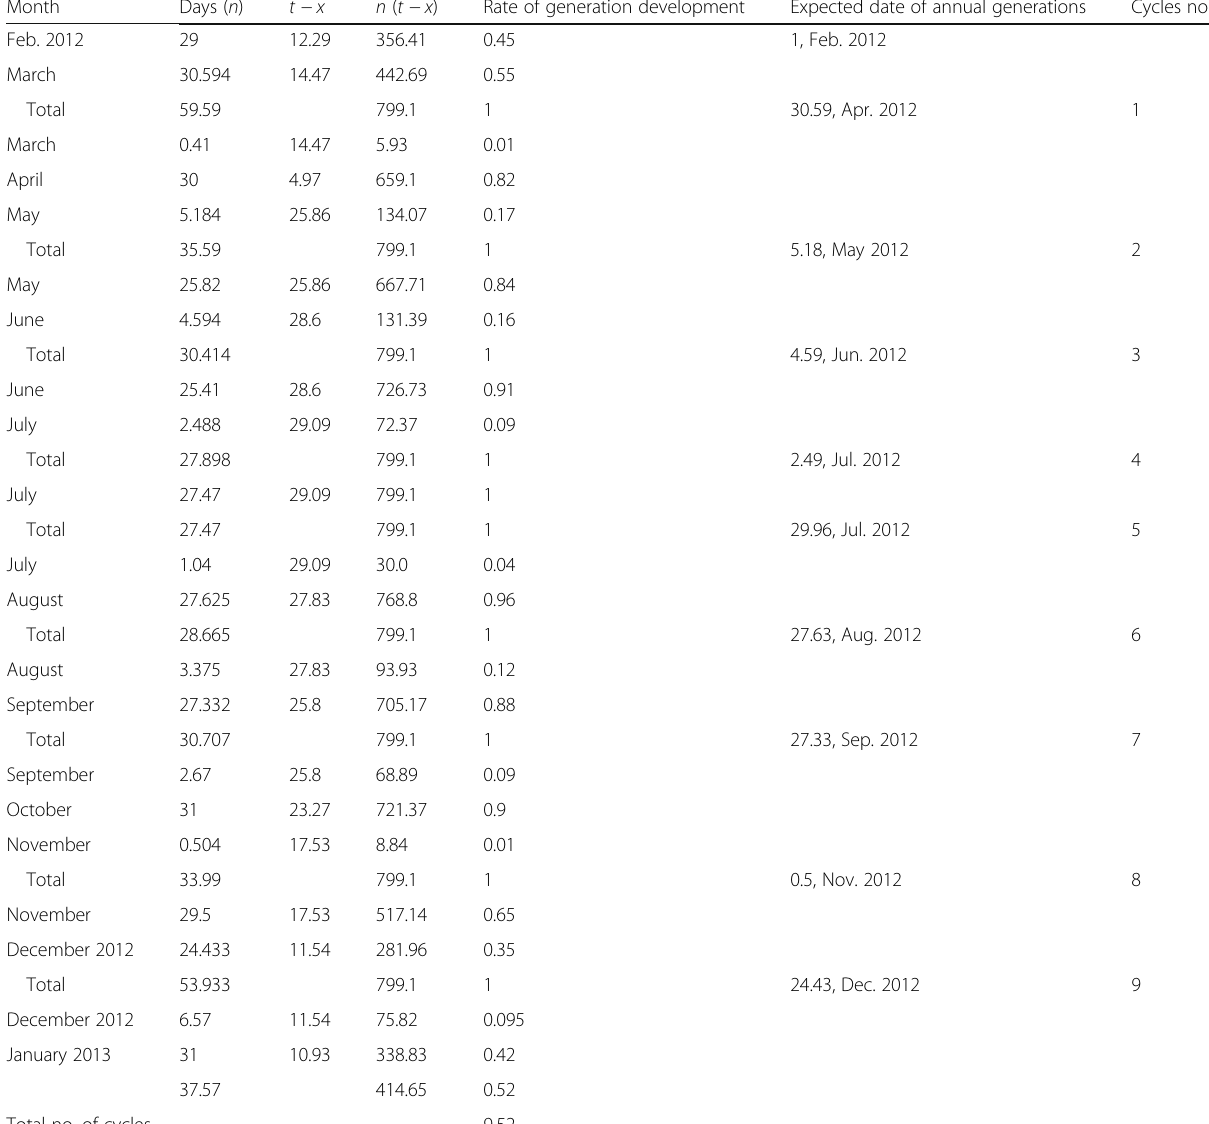
Table 5 Expected frequencies of annual generations of Tuta absoluta during 2012 in Qena governorate Month Days ( n ) n ( t − x ) Rate of generation development Expected date of annual generations Cycles